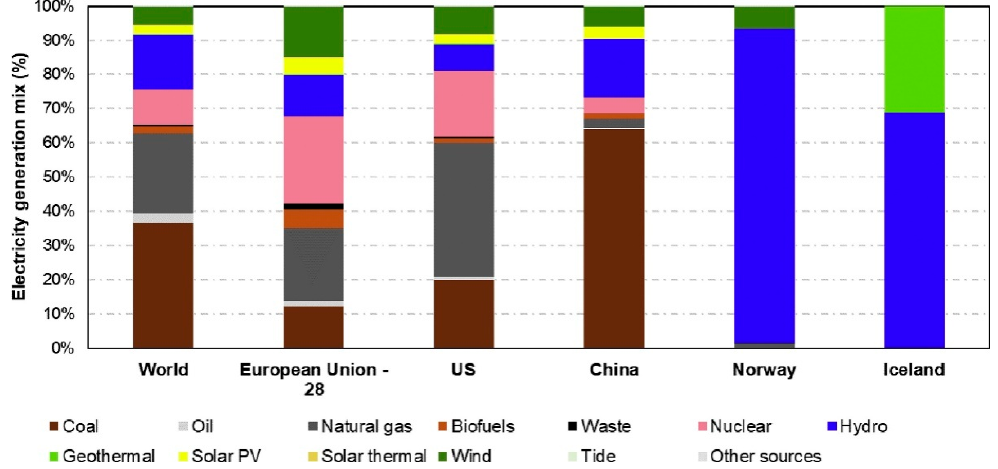
Figure 4. Electricity generation mix in 2020 [15].